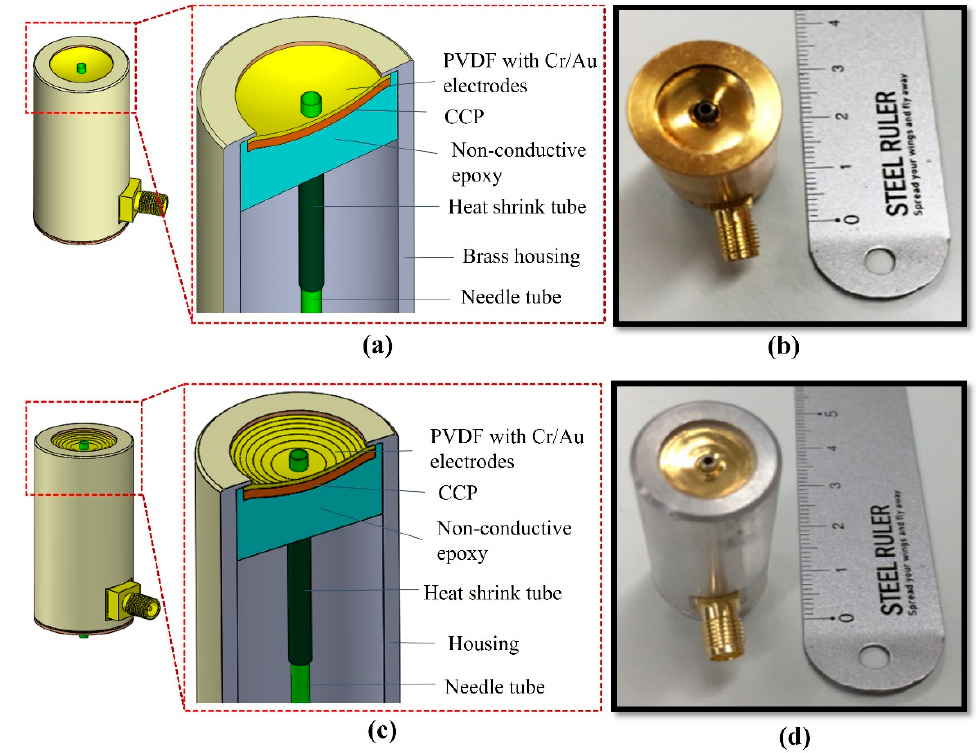
Figure 5. (a) A cross sectional view and (b) SFP ring-shaped transducer photograph. (c) A